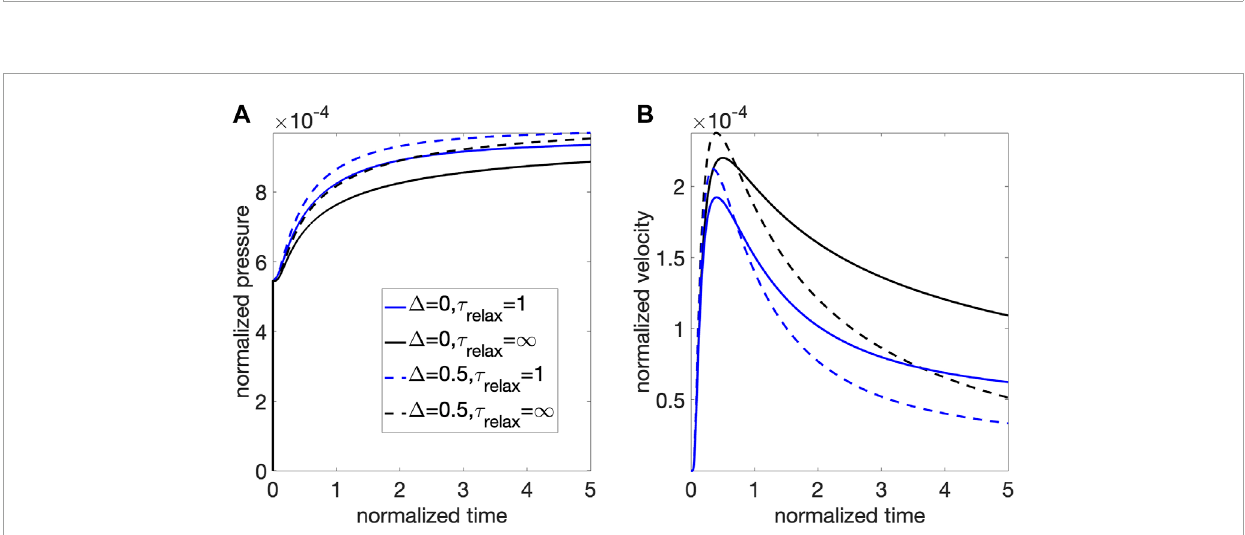
FIGURE 7 Pressure (A) and melt velocity (B) at z = 1 (normalized) shown as functions of time following a step increase in fluid pressure at z = 0. Solid lines correspond to a mush column with no background temperature gradient, dash lines correspond to a mush column with a negative background temperature gradient (hotter at the source). Black lines correspond to a mush column with no viscous relaxation (i.e., infinitely long relaxation time); blue lines correspond to a mush column with viscous relaxation time τ relax = [ t ] (the poroelastic diffusion time). Other parameters used for (B)